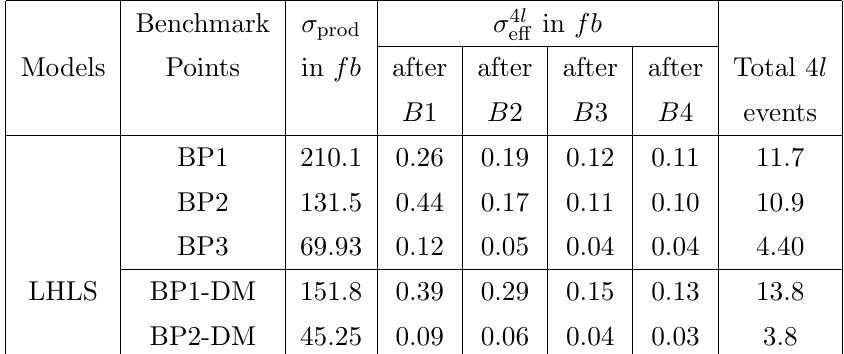
for the BPs de(cid:12)ned in table 5 e(cid:11)